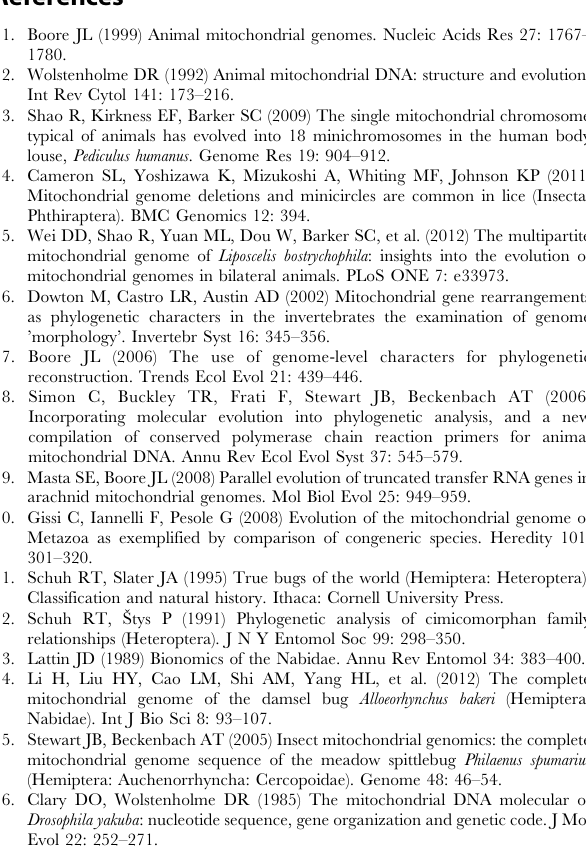
Table S2 Codon distribution in six nabid mtDNAs. (DOC) Table S3 Evolutionary rates of six nabid mitochondrial PCGs. Table S4 Statistics on NC sequences in six nabid mitogenomes. Table S5 Occurrence of tandem repetitions in six nabid mtDNA NC regions. Table S6 Information of five sequenced nabid species included in the present study. Table S7 Primer sequences used in this